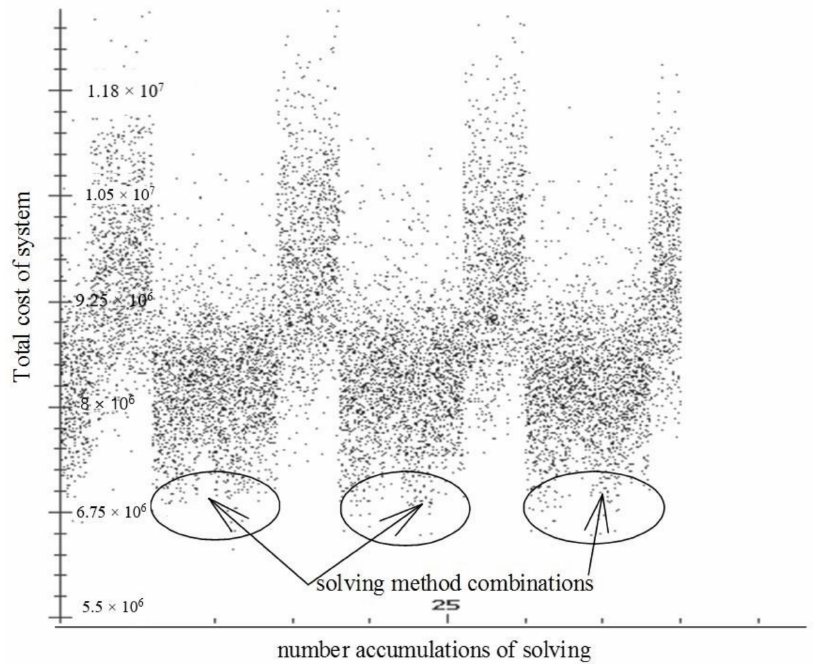
Figure 6. Combinations of resolving methods and distribution of solutions.